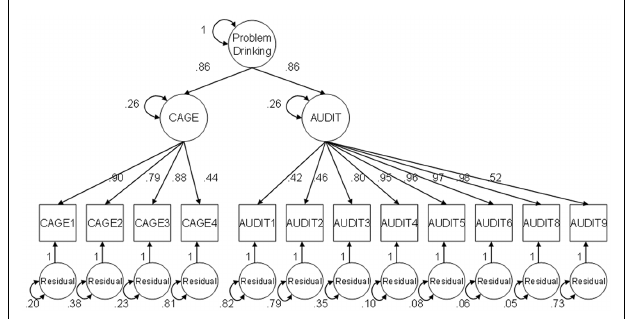
FIGURE 1 | Higher-order two-factor model for the items of two problem drinking scales, theAUDIT and CAGE. Note: single-headed arrows represent standardized factor loadings, double-headed arrows represent total variance for the Problem drinking factor and residual variances for all other factors depicted in the figure. Factor loadings of 1 are fixed parameters, the factor loadings of problem drinking on CAGE and AUDIT are constrained to be equal; these constraints ensure that the factor model is identified.